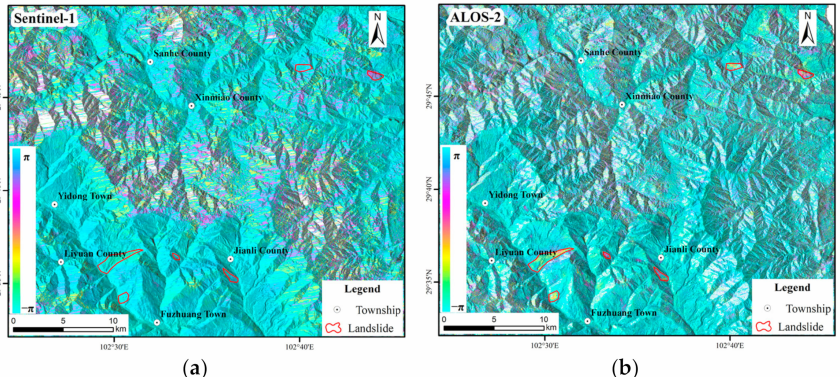
Figure 21. Comparison of Stacking-InSAR results of different waveband data in high-density vegeta- tion coverage areas. ( a ) The result of Sentinel-1 data; ( b ) the result of ALOS-2